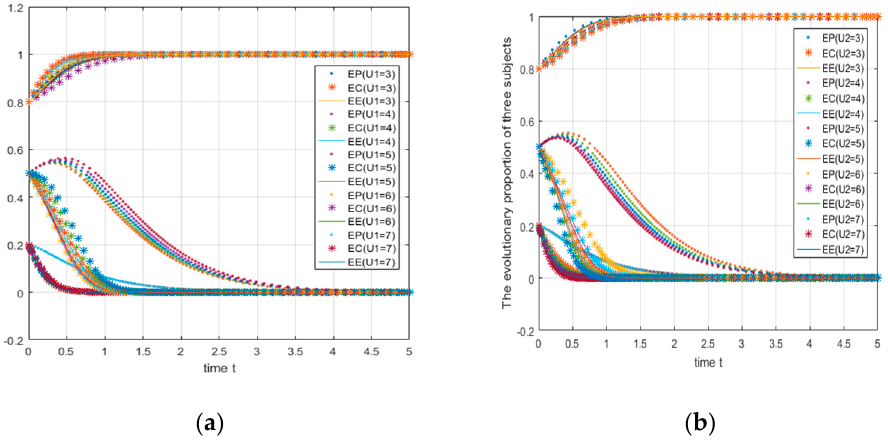
Figure 7. Evolutionary image when only the parameters of consumers’ consistent behavior change.